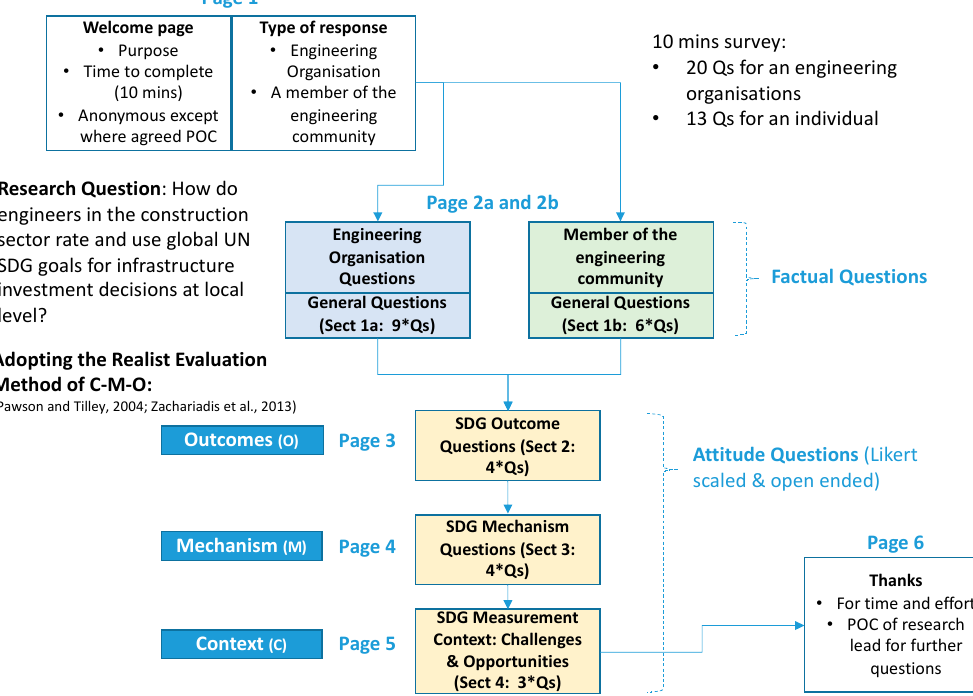
Figure 5. Survey Questions Sequence; adopting Realist Evaluation methodology of Context-Mechanism-Outcomes (Pawson et al. 2005; Zachariadis et al. 2013). (See Appendix A for the full table of questions).